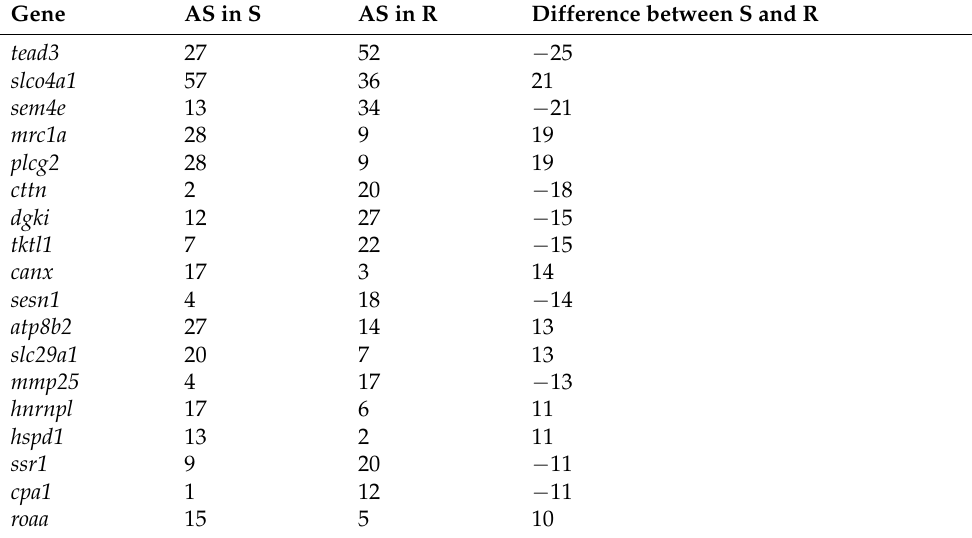
Table 4. List of genes that difference of alternative splicing number ≥ 10 between S and R.